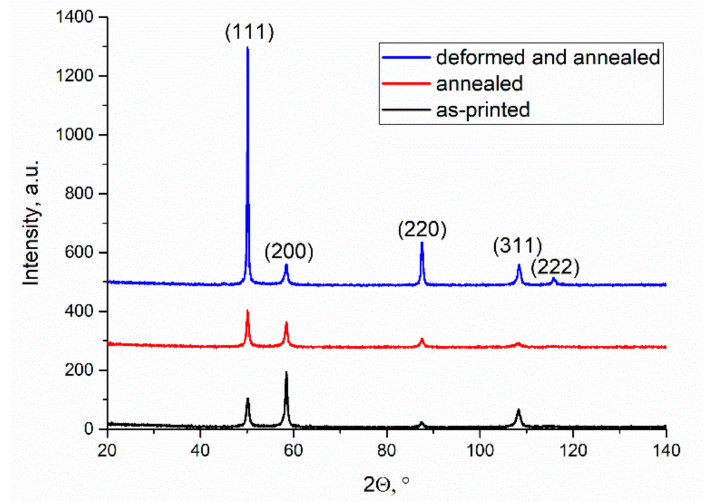
Figure 6. An XRD pattern for the printed Cu-7.5wt.%Al bronze samples with only FCC phase